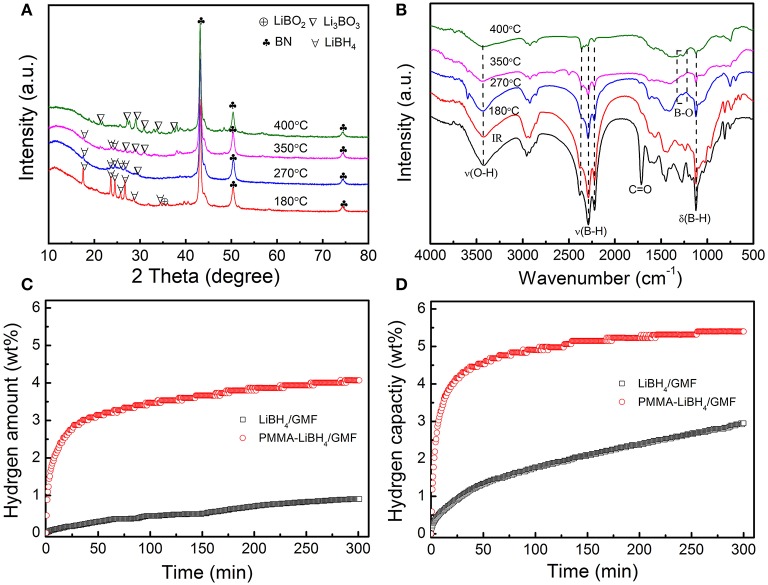
XRD (A) and FTIR (B) patterns of dehydrogenated of PMMA-LiBH4/GMF at 180, 270, 350, and 400°C and the isothermal hydrogen desorption curve of LiBH4/GMF, PMMA-LiBH4/GMF (C,D).